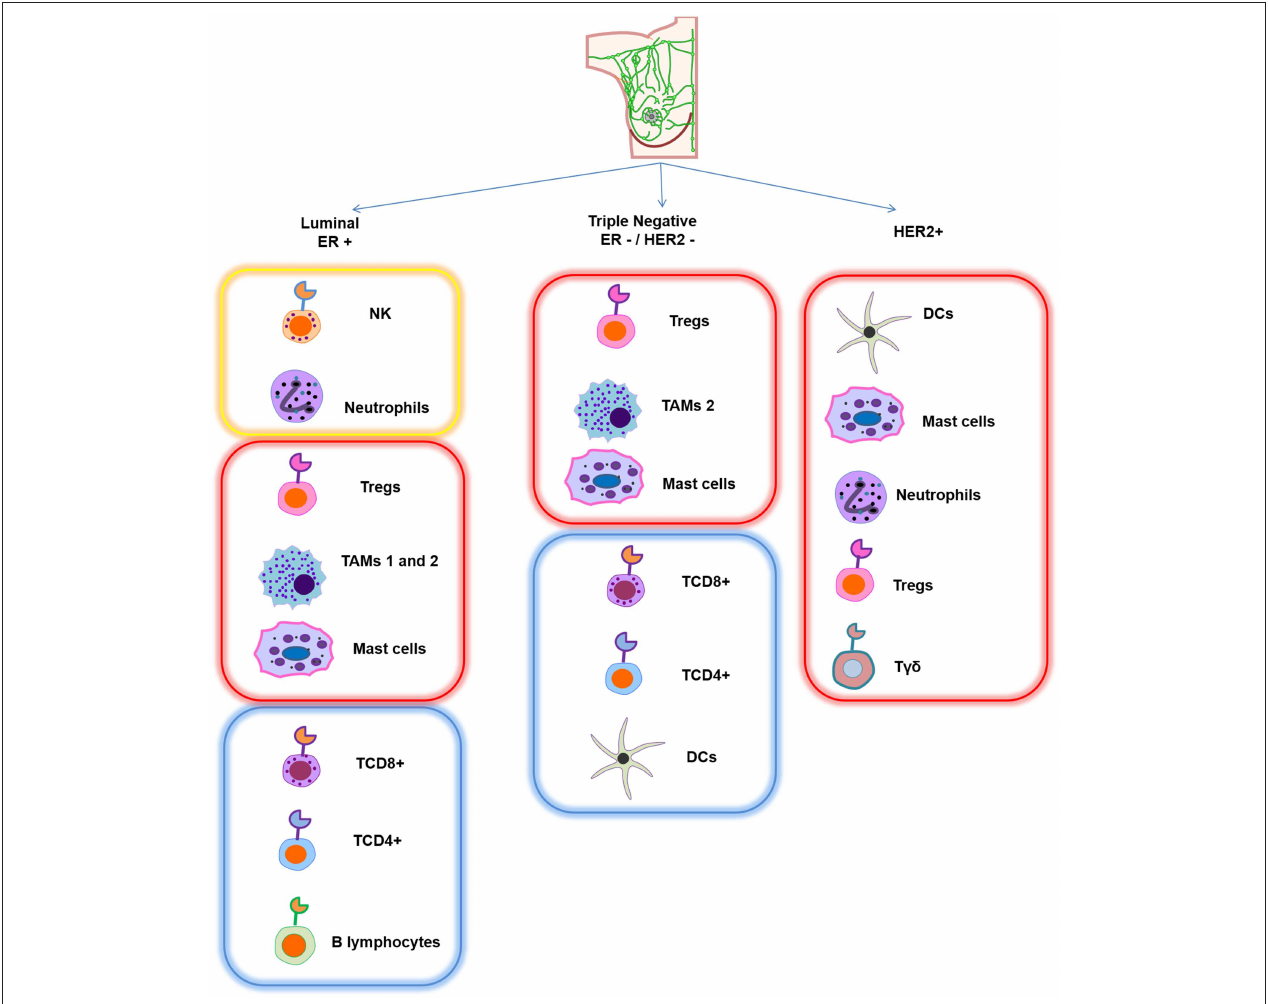
FIGURE 1 | Schematic representation of the main infiltrating immune cell pattern in different breast cancer subtypes. Each subtype has a different composition of immune cells. Yellow frame represents strong presence of specific immune cells that confer good prognosis, red frame indicates that this infiltrating signature is associated with poor prognosis, and blue frame corresponds to a lower proportion of immune cells, which is also associated with good